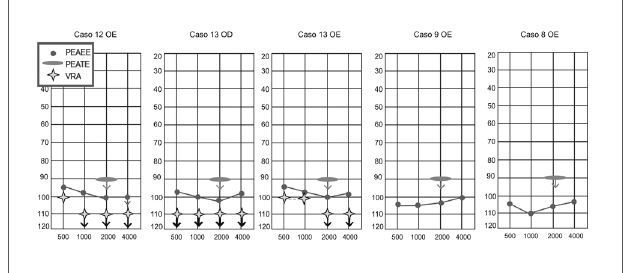
Figura 2. Exemplos de casos da comparação dos PEATE-clique com os PEAEE II. - PEAEE: Potenciais Evocados Auditivos de Estado Es- tável; PEATE-clique: Potencial Evocado Auditivo de Tronco Encefálico com o estímulo clique; VRA: Audiometria de Reforço